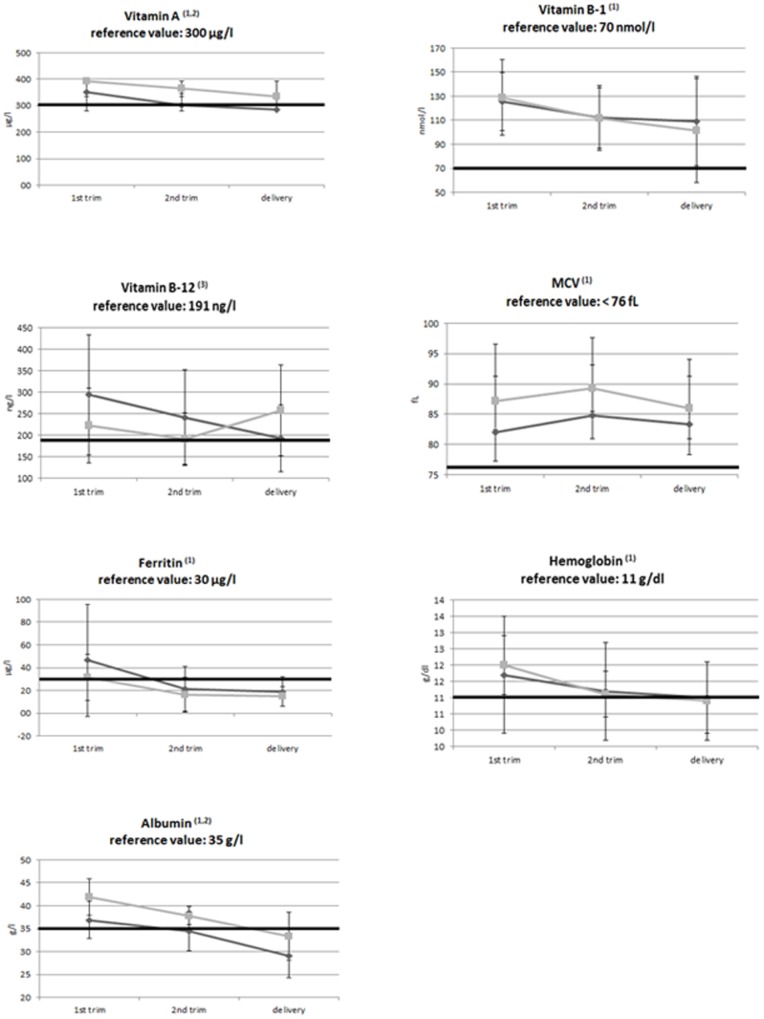
Mean (±SD) concentrations of various markers of nutritional/health status.light grey = malabsorptive group. dark grey = restrictive group. 1 = significant time effect. 2 = significant group effect. 3 = significant time x group effect.